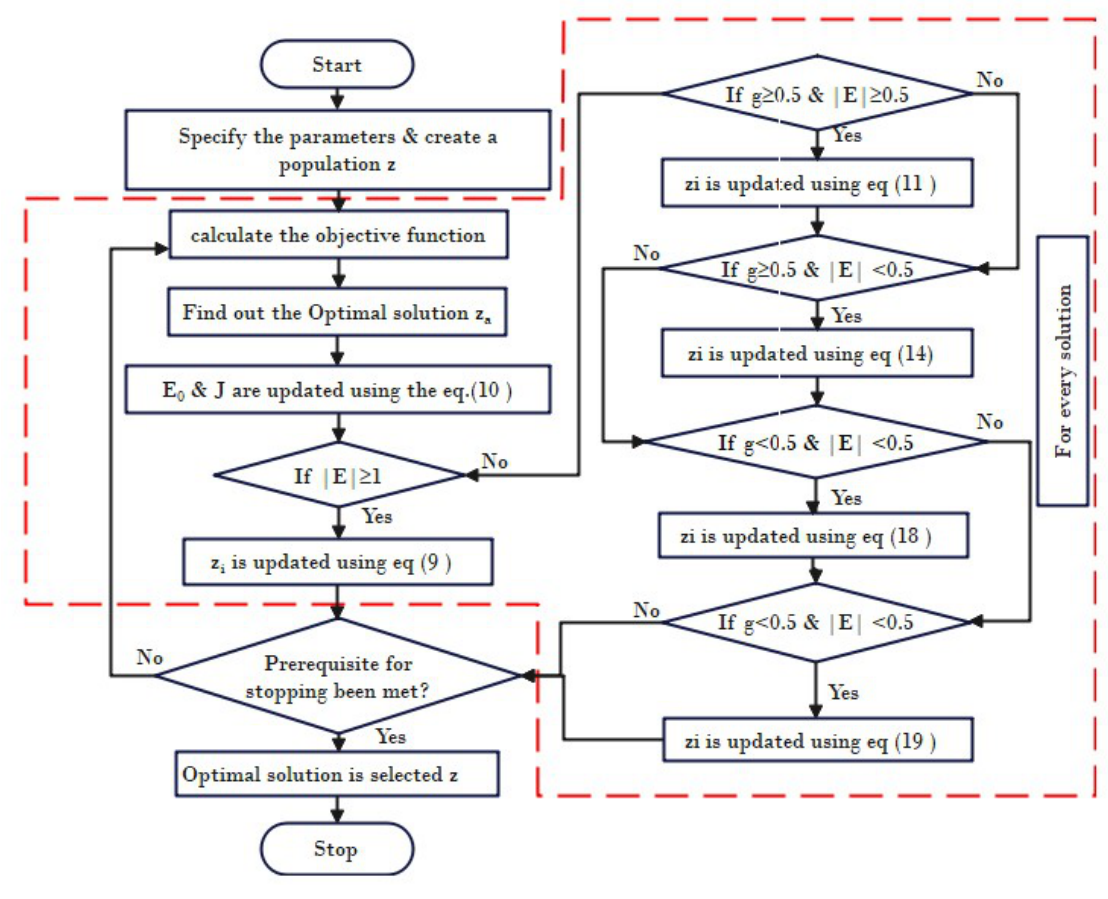
Figure 8. The Procedure of